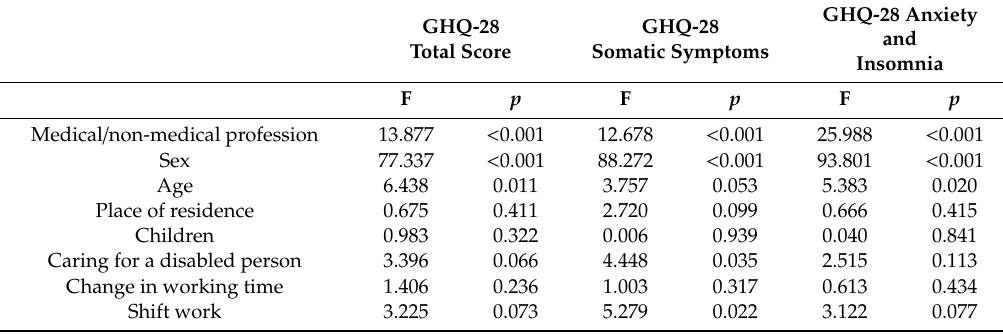
Table 3. Psychopathological expressions in medical and non-medical professionals after adjustment for potential confounding